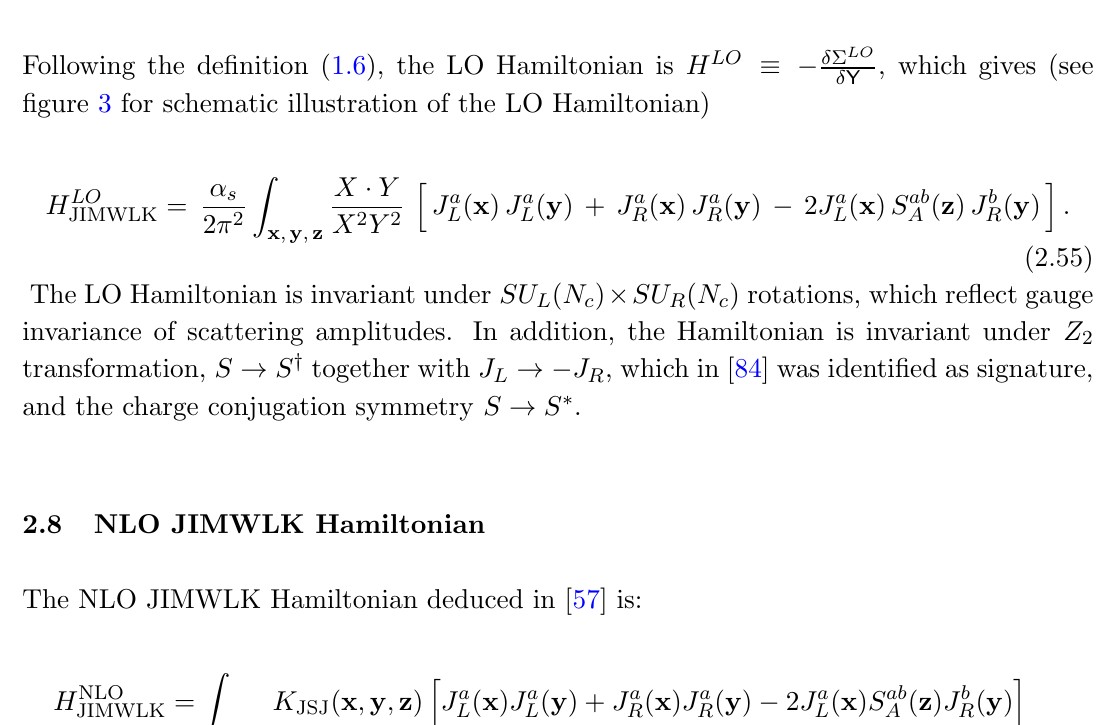
Figure 3 . Figures ( a ) and ( b ) correspond to the contributions from the normalisation of the wave function, while the (cid:12)gure ( c ) illustrates the real gluon scattering contribution. The instantaneous shockwave interaction between the projectile and the target is represented by the thick (red) line. Each operator J L =J R in the JIMWLK Hamiltonian correspond to the emission vertice of a soft gluon from the valence